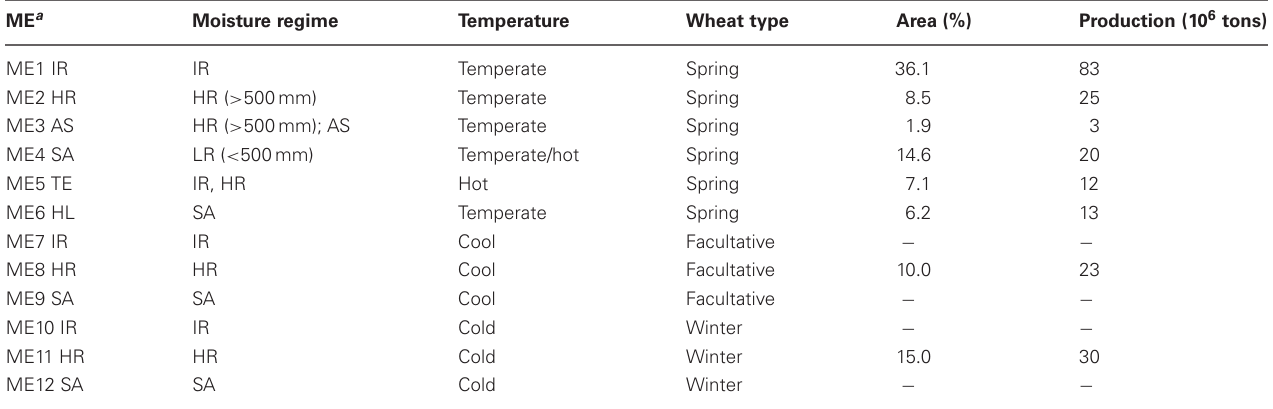
Table 2 | The main wheat mega-environments (Source: Rajaram et al.,